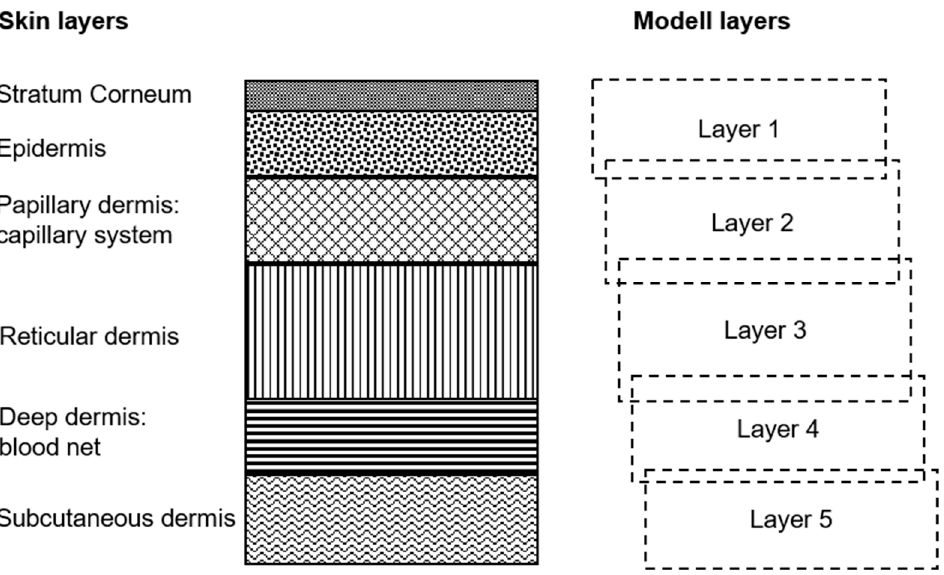
Figure 8. Five-layer skin model.